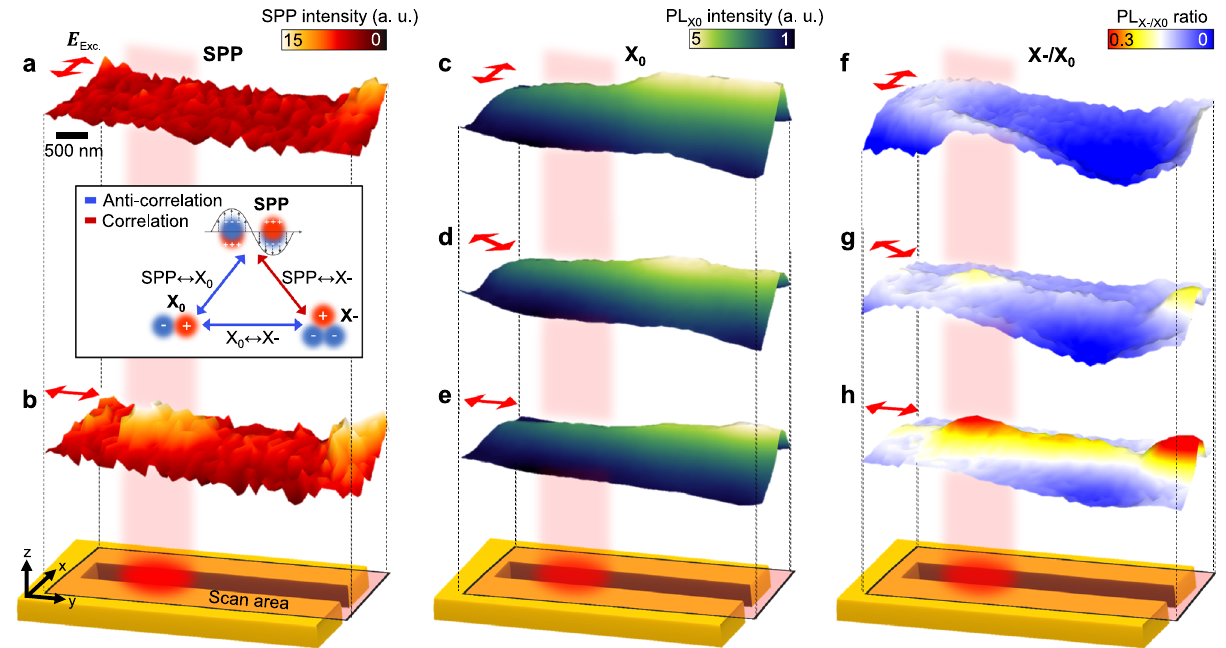
f – h PL images of X-/X 0 ratio with different excitation polarizations. Illustration of scan area on the waveguideisbasedon Rayleigh scattering image(Supplementary Figs. 4 and 5). Inset: (Anti-) correlation between SPP, X 0 , and